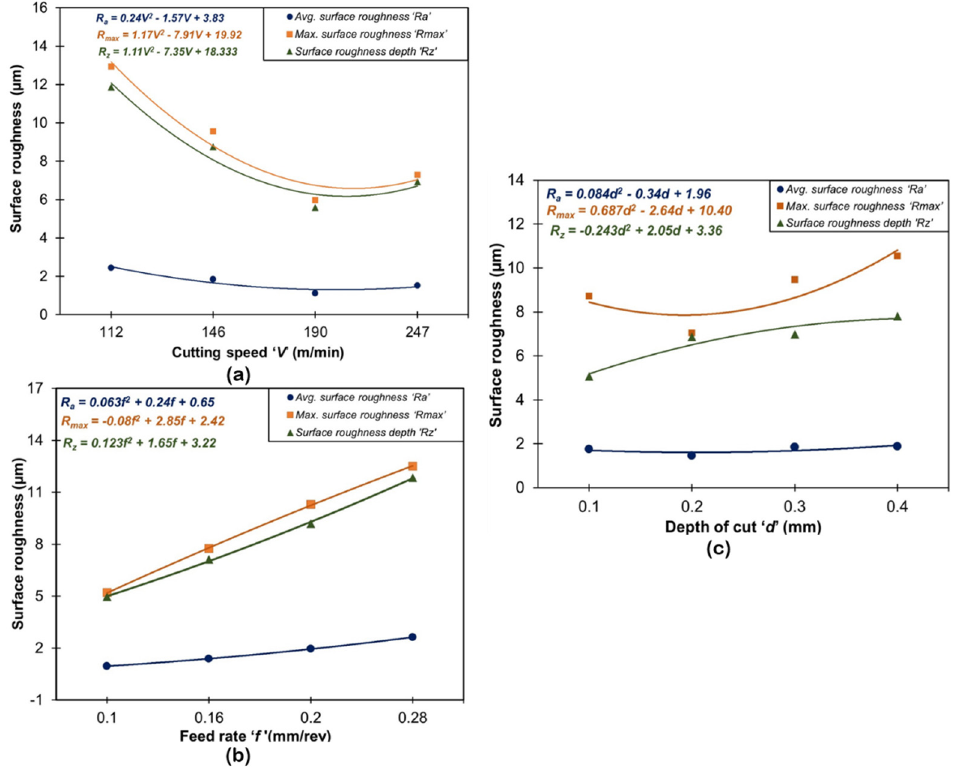
Figure 4. Variation in surface roughness parameters under the influence of: ( a ) speed; ( b ) feed; ( c ) depth of cut.